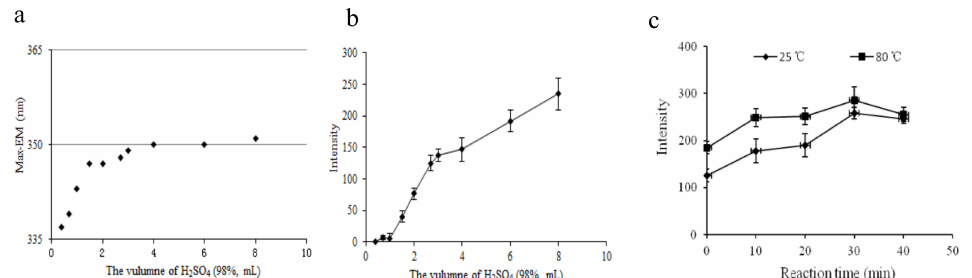
Figure 2. Effect of conditions on the fluorescence characteristics: ( a ) volume of H 2 SO 4 (98%) on the maximum emission wavelength, ( b ) volume of H 2 SO 4 (98%) on the fluorescence intensity, ( c ) reaction time and temperature on the fluorescence intensity of the aqueous DBP